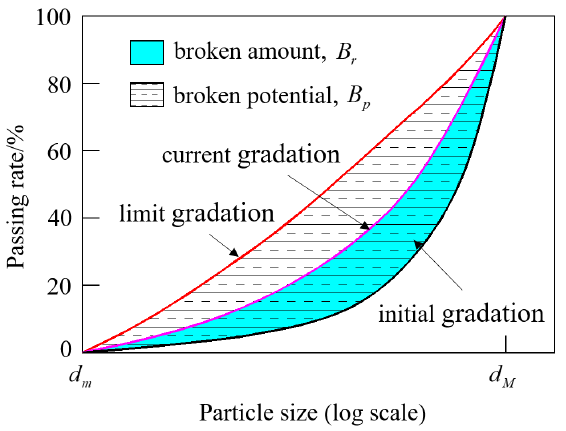
Figure 10. Schematic diagram of calculation of relative crushing rate.